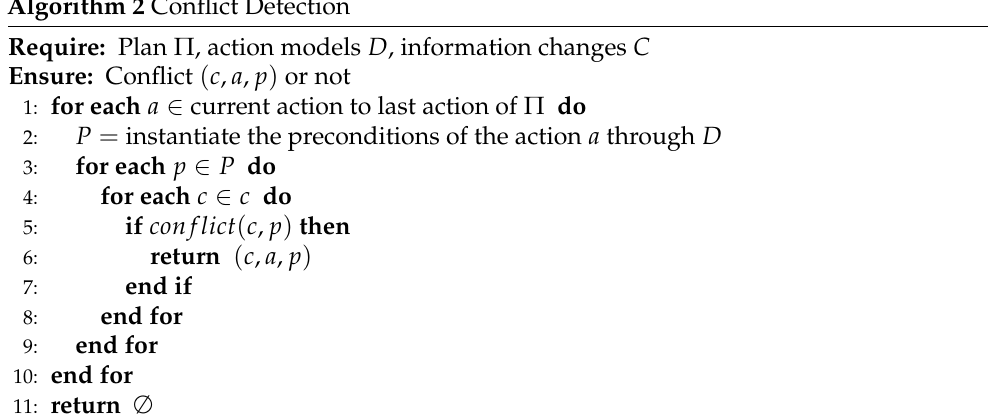
Algorithm 2 Conflict Detection